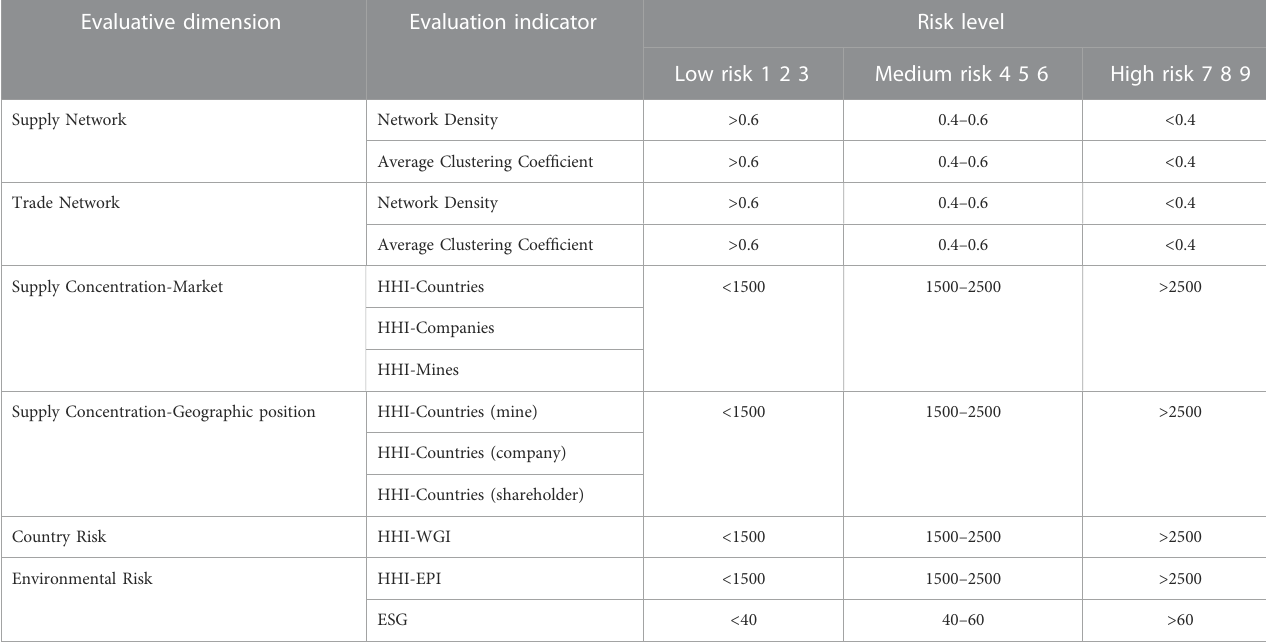
TABLE 2 Risk assessment of the global platinum supply